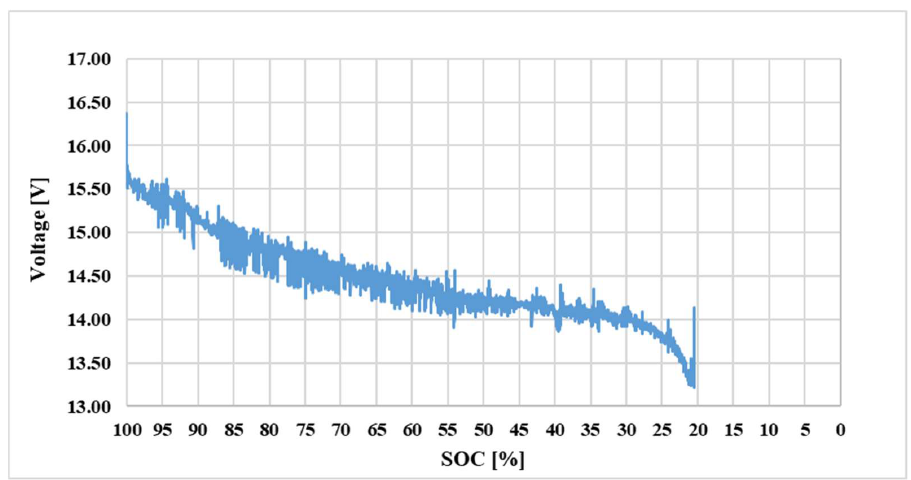
Figure 8. In-flight monitored voltage and current measurements. Figure 8 shows the voltage in blue and the current in red. The average load was 8.2 A, corresponding to 2.2C. In Figure 9, the variation of the voltage and the SOC can be found.